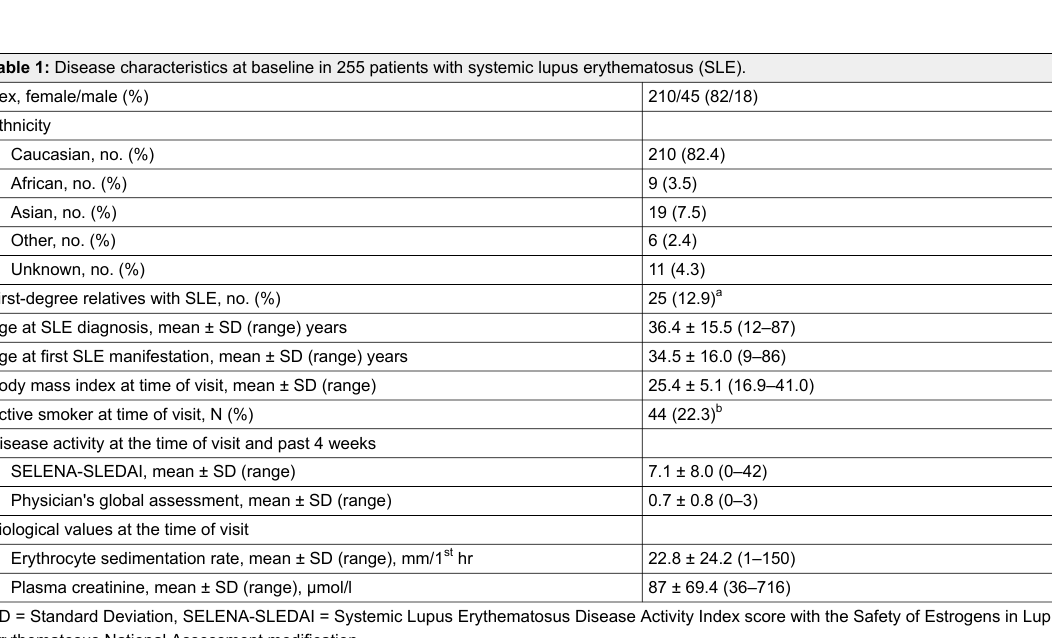
Table 2: Disease characteristics by medical specialties in 255 patients with systemic lupus erythematosus (SLE). Medical specialty